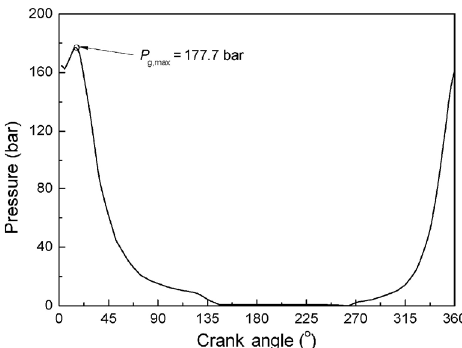
Fig. 5 Piston gas pressure with crank angle.